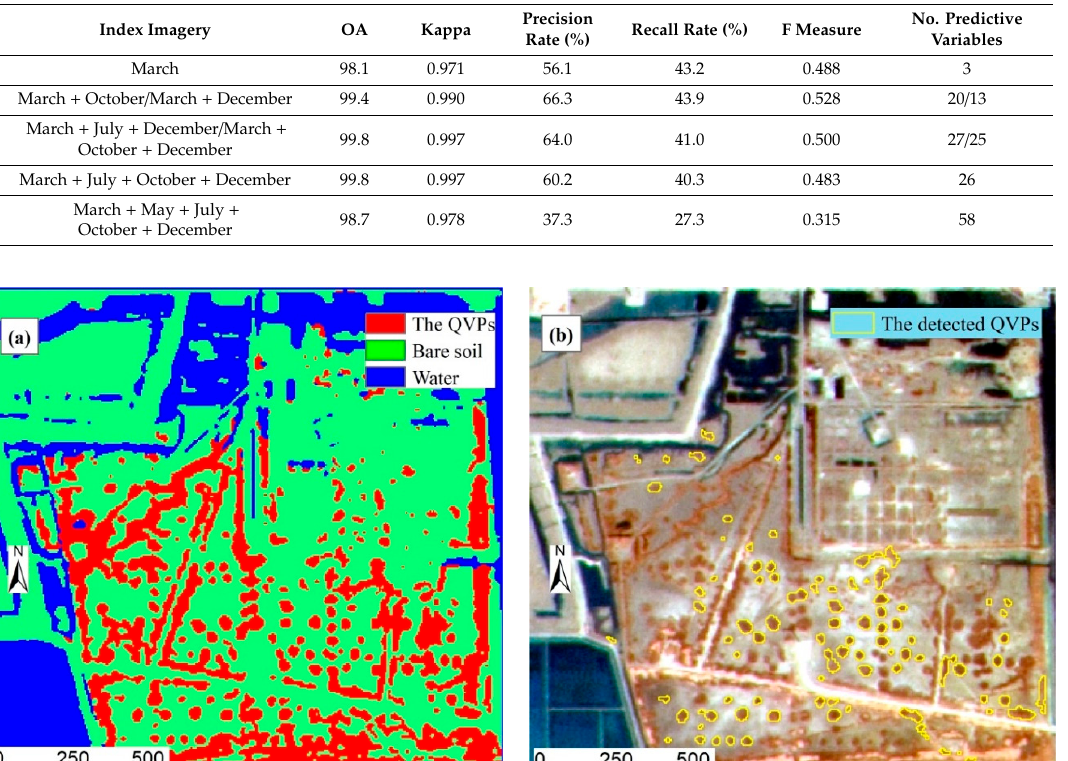
Table 9. A summary of the QVP classification accuracies from the individual season imagery and season combined images using the random forest classifier.